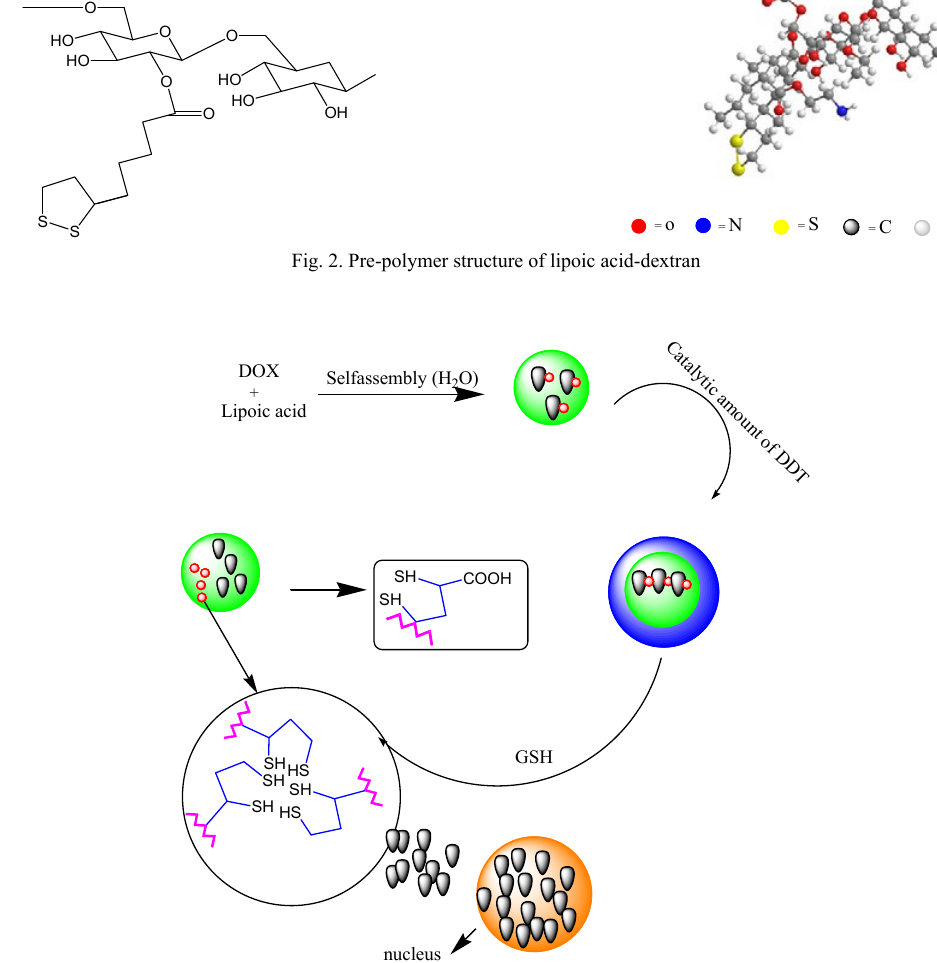
Fig. 3. Stages of nanogel synthesis and the release of the drug in the target Fig.3 Stages of nanogel synthesis and the release of the drug in the target cell